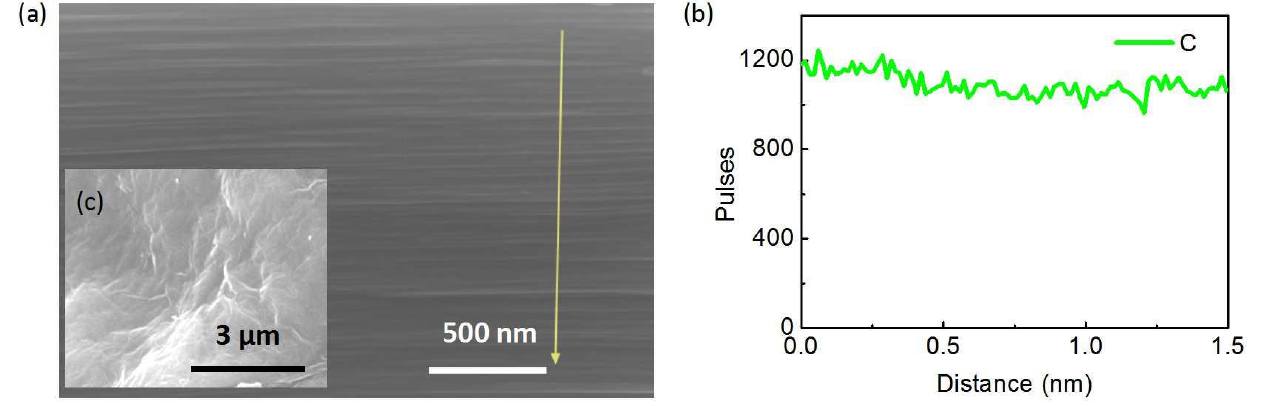
Figure 3. SEM images: ( a ) the cross-section of the graphite film, ( b ) the line scanning test, and ( c ) the surface of the graphite film.